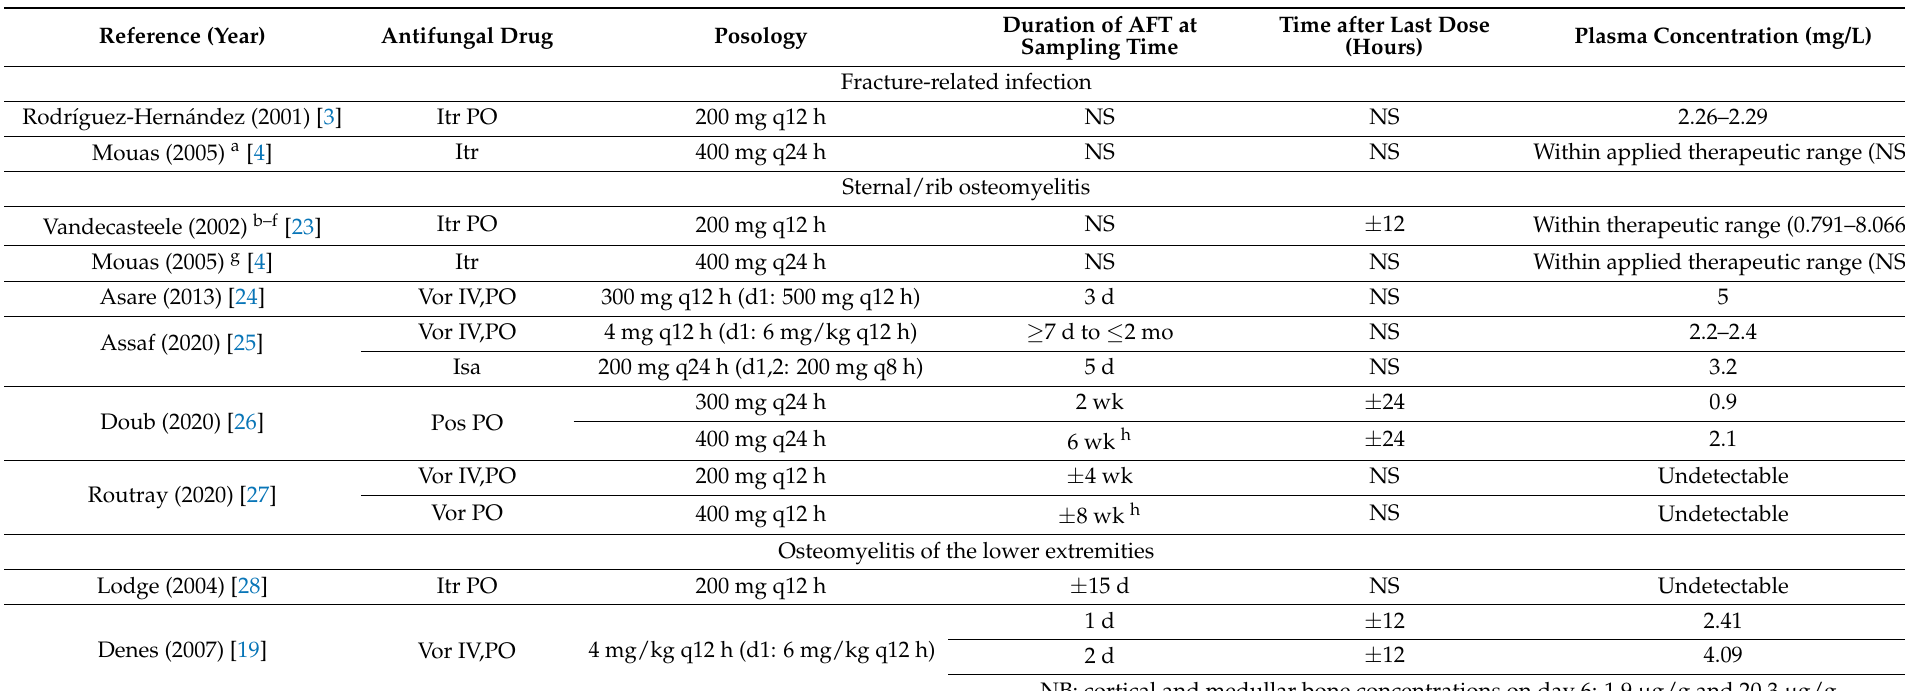
Table 2. Aspergillus osteomyelitis cases with documented therapeutic drug monitoring for itraconazole, voriconazole or posaconazole ( n =